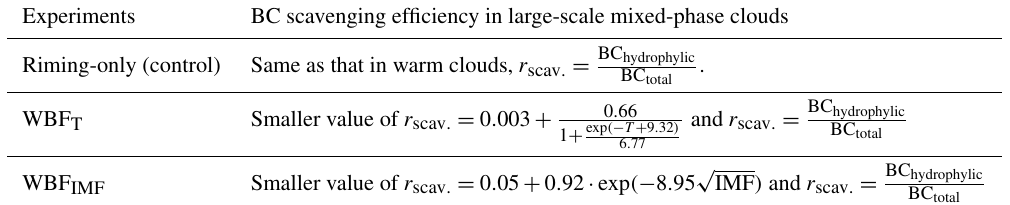
Table 4. GEOS-Chem simulations of global BC distribution. Experiments